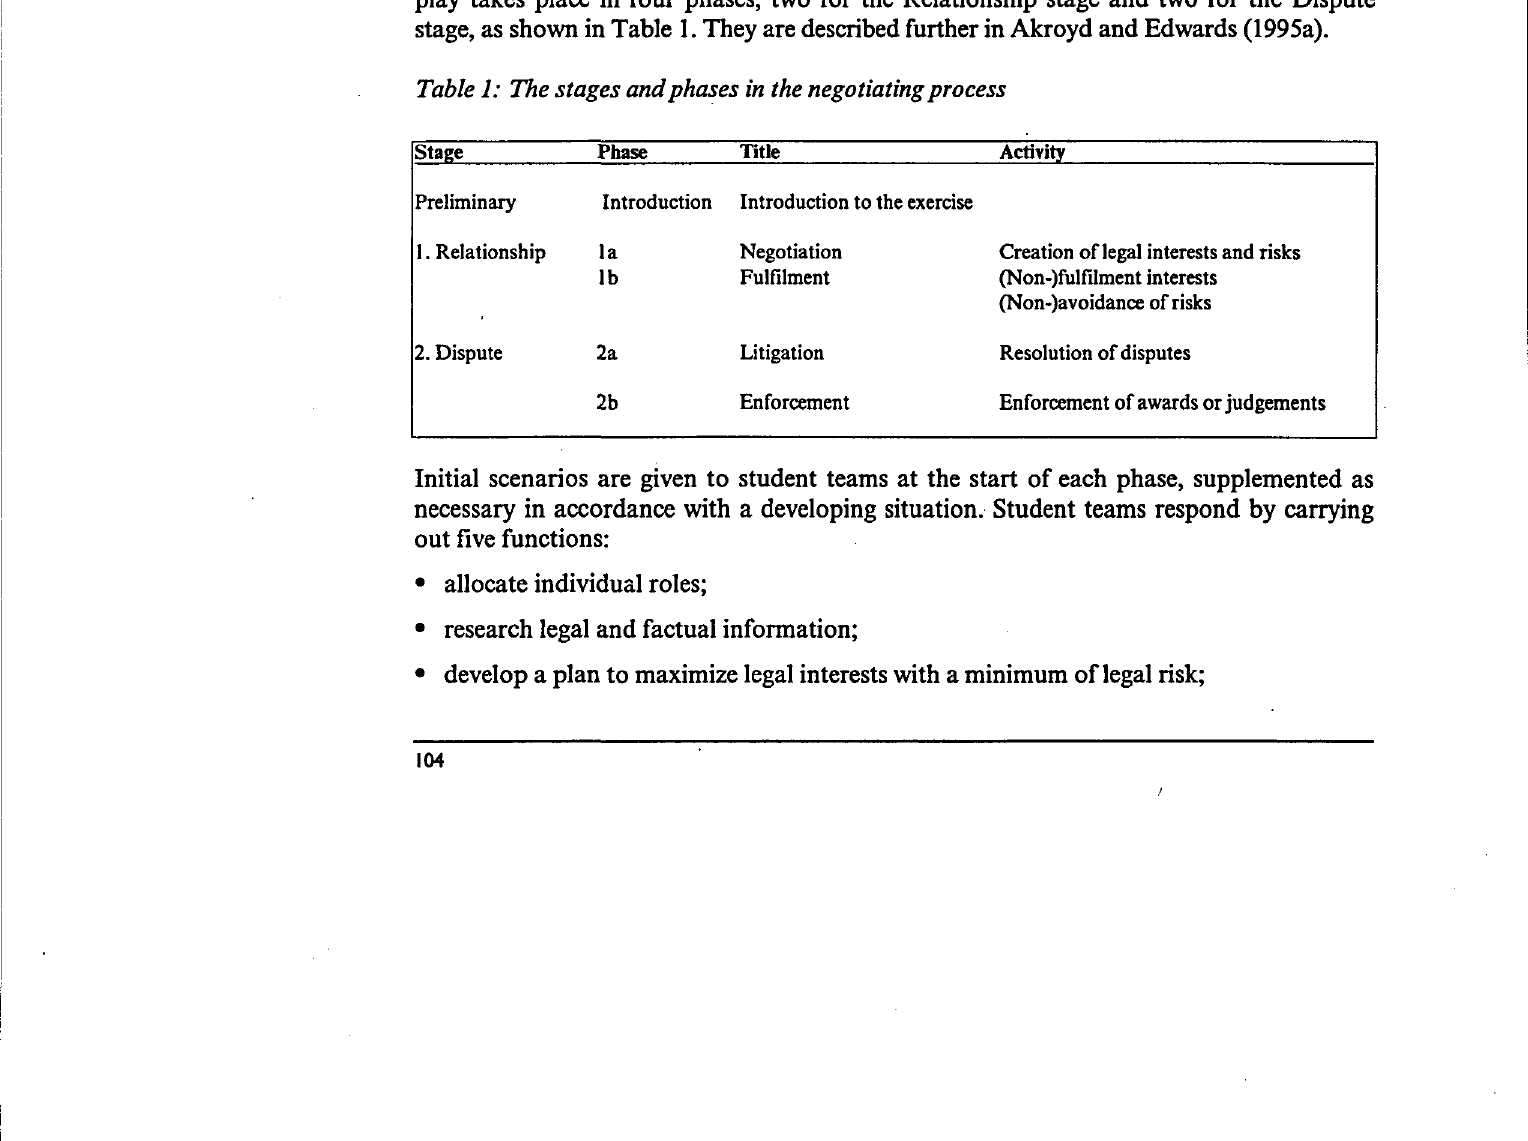
Table 1: The stages and phases in the negotiating